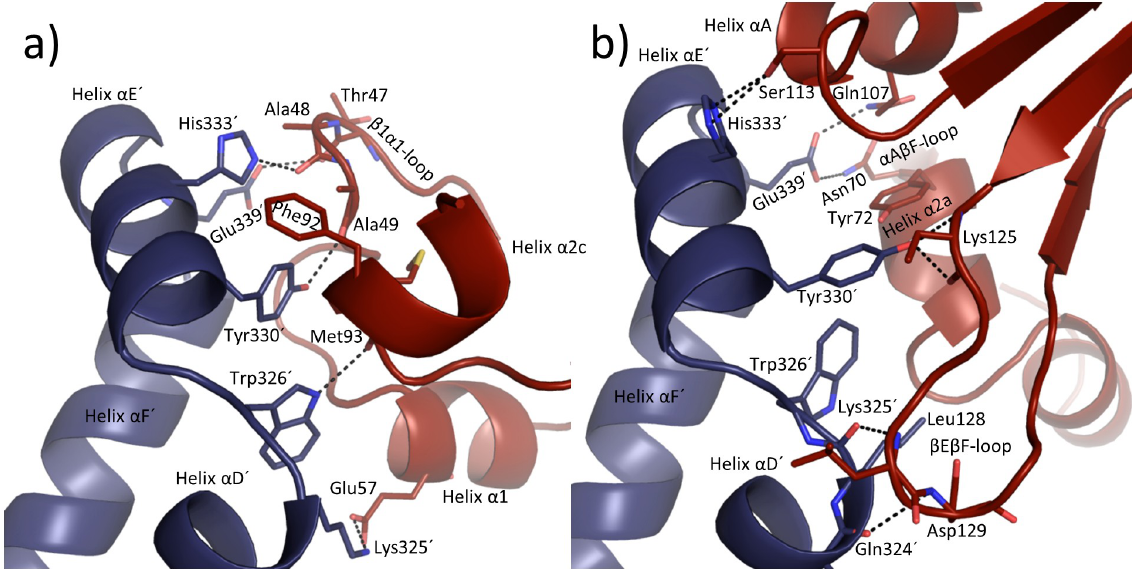
Fig 7. Illustration of the aromatic hot spot regions. H-bondsand salt bridges are displayedas black dashedlines. a) Arrangement of the aromatic hot spot regionformed in apo-TGT (PDB entry: 1P0D[18]). The β 1 α 1-loop of the loop-helixmotif shieldsthis region from water access and can be perturbedby inhibitor binding(monomer1 red, monomer2 blue, space group C 2). b) New arrangementof the hot spot region in the twisted dimer found in TGT (cid:1) 9 co (monomer1 red, monomer 2 blue, space group P 2 1 ).